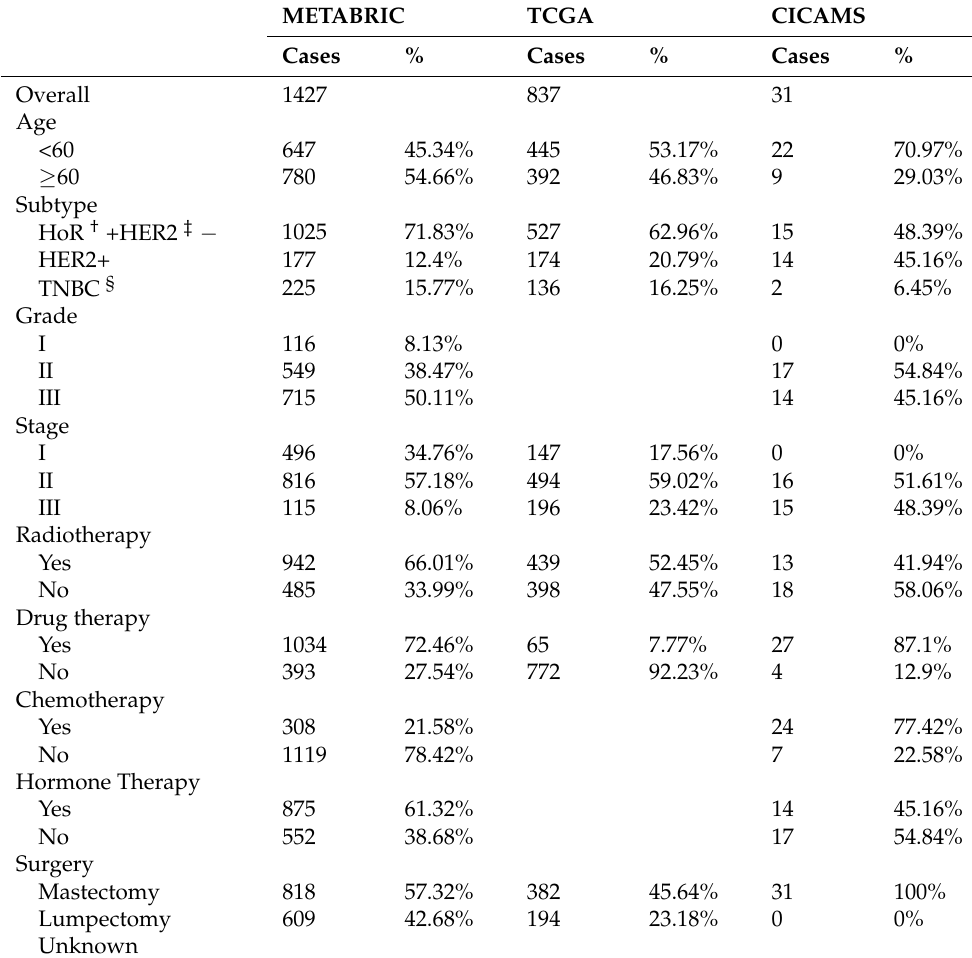
Table 1. Clinical characteristics and treatment